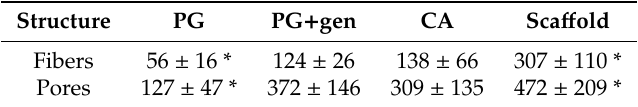
Figure 1. SEM images showing the fibers morphology spun from ( a ) polyvinyl pyrrolidone (PVP) and gelatin solution, ( b ) PVP and gelatin with gentamicin, ( c ) cellulose acetate solution, ( d ) cellulose acetate layer on top of polyvinylpyrrolidone:gelatin (PG)+gentamicin (gen) layer and ( e ) PG+gen layer on top of cellulose acetate layer. Table 1. Average diameter of fibers and pores.